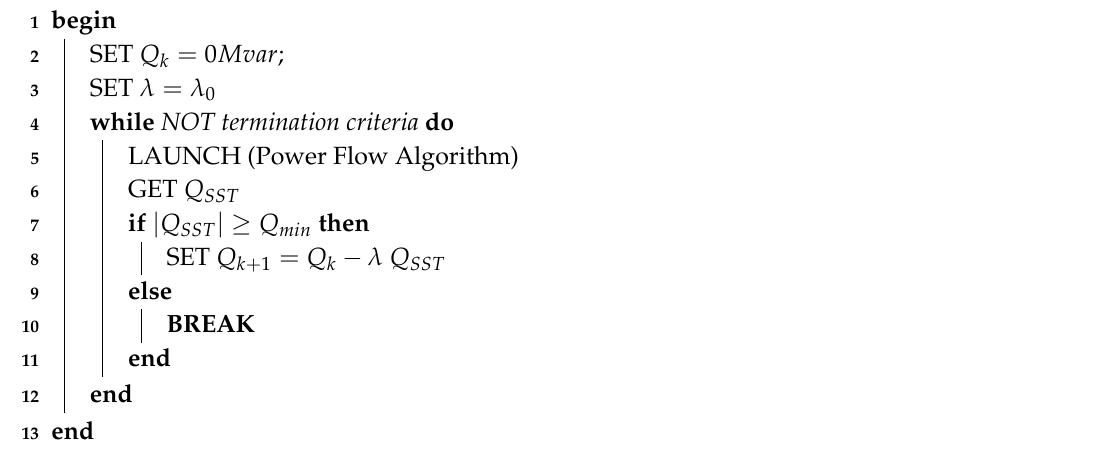
Algorithm 1: Reactive Power Compensation Using Fixed Steepest Descent Method